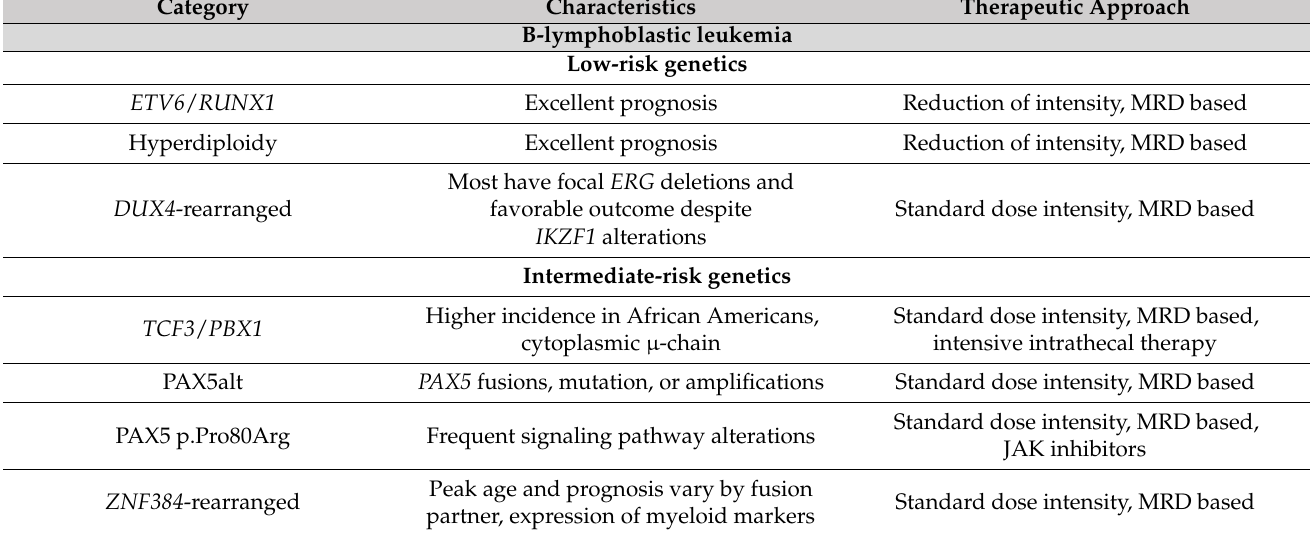
Table 2. Genetic subtypes and treatment